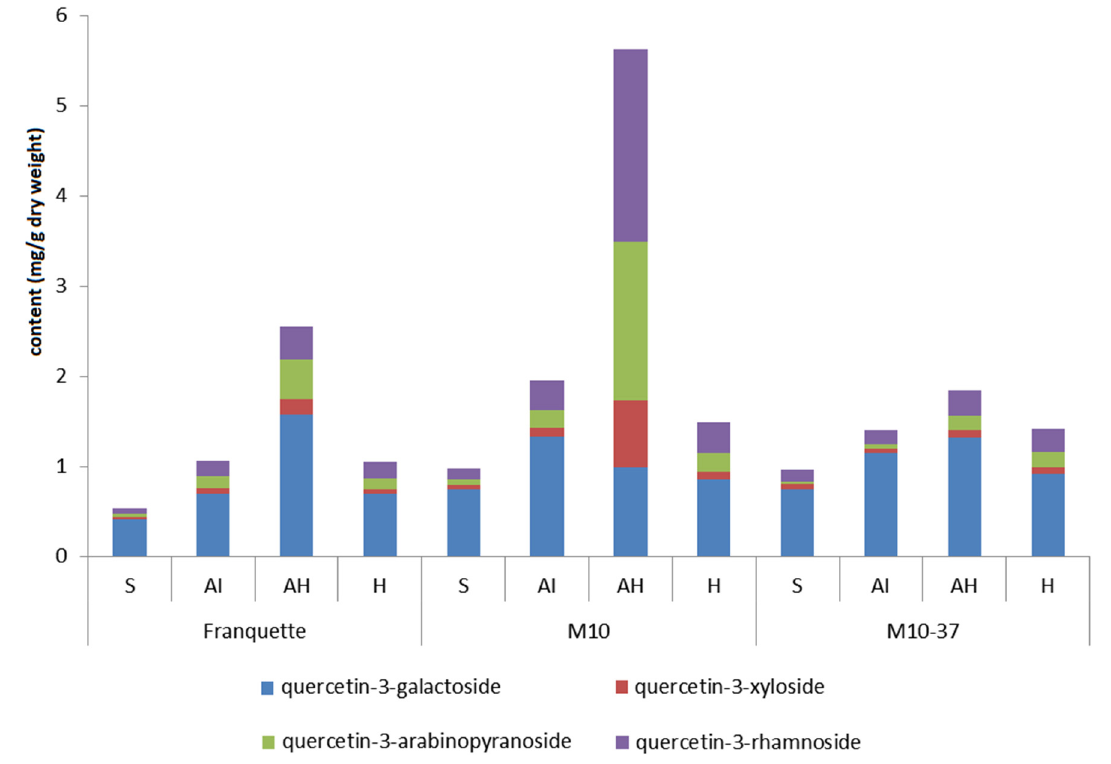
Figure 5. Contents of flavonols identified in different severity of walnut anthracnose-affected tissues of J. regia husk, between three cultivars: susceptible ‘M10-37’, semi-susceptible ‘M10’ and least susceptible ‘Franquette’ (in mg/g dry weight). S: inner spot of infected tissue; AI: outer margin of infected tissue; AH: healthy tissue surrounding the infection; H: healthy tissue.